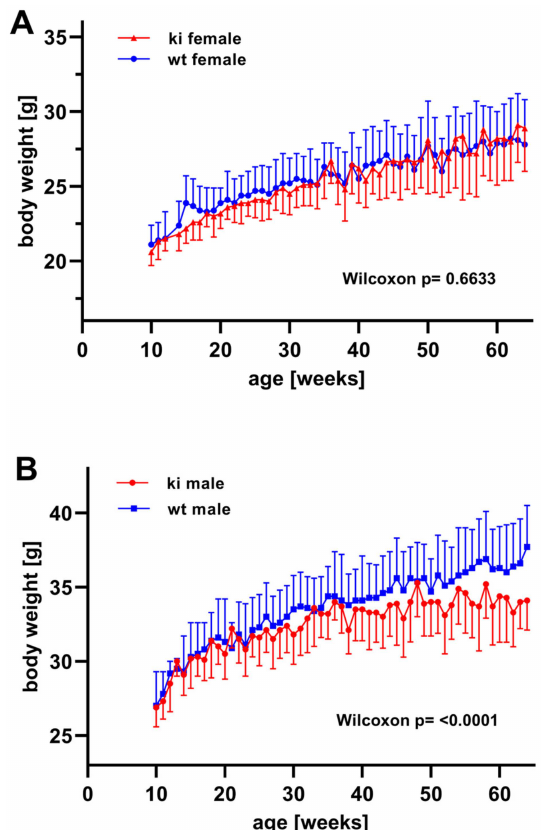
Figure 6. Comparison of the body weight kinetics of Alox15b -KI mice and outbred wildtype controls. For each genotype, 10 individuals of either sex were housed in separate cages (5 mice/cage) with water and food (standard chow diet) ad libitum. Absolute body weights were quantified once a week, covering the developmental period between 10 and 64 weeks. ( A ) Female individuals, ( B ) male